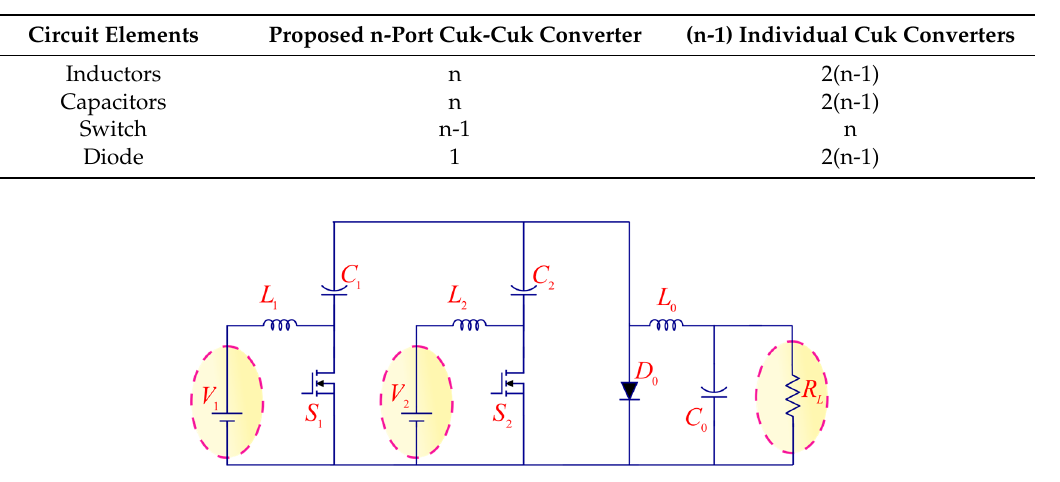
Figure 4. Proposed three-port converter.